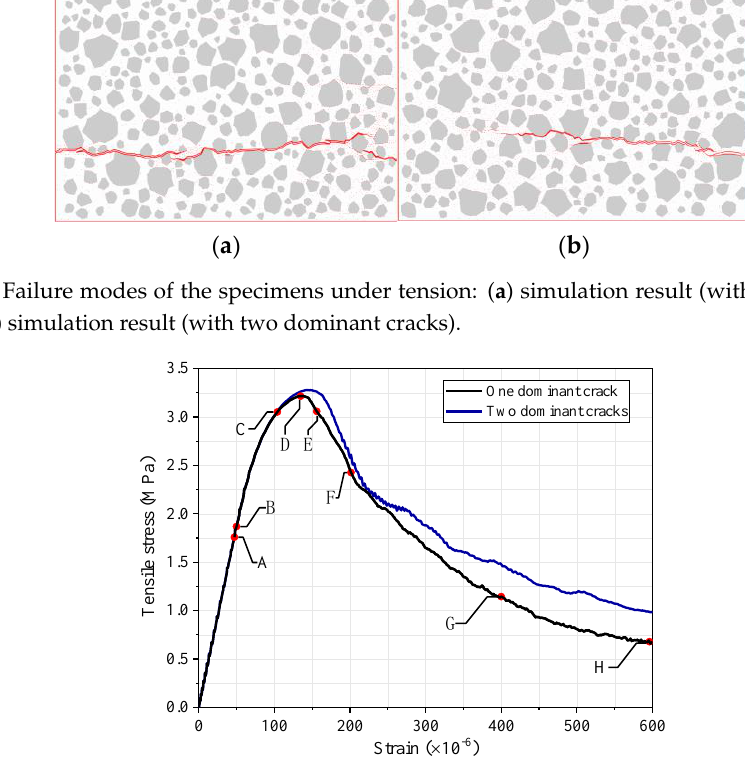
Figure 9. Global stress-strain curve of the specimens with one and two dominant cracks.